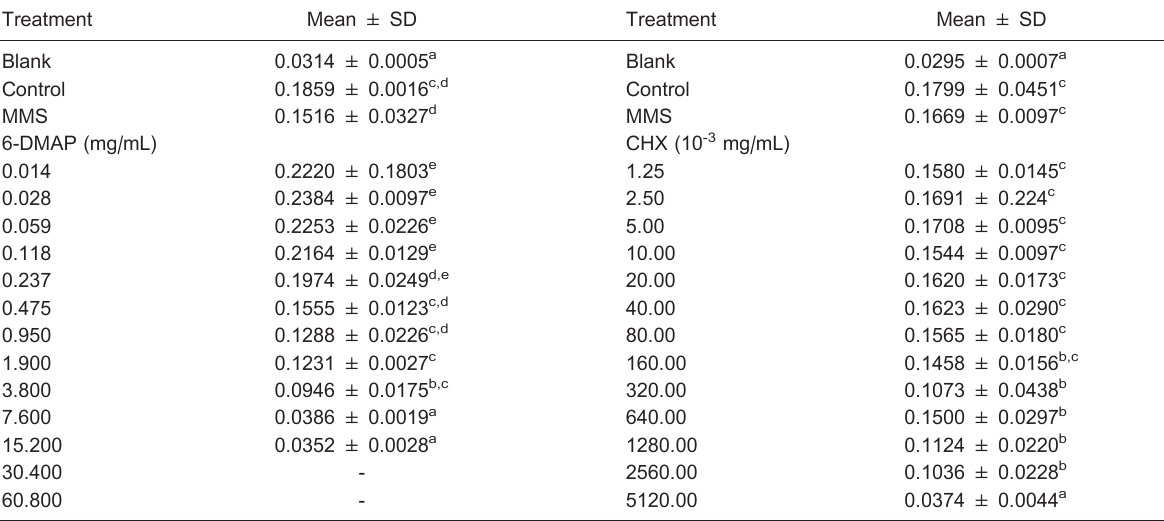
Table 1. Mean absorbance values ± SD in the thiazolyl blue tetrazolium bromide colorimetric assay.